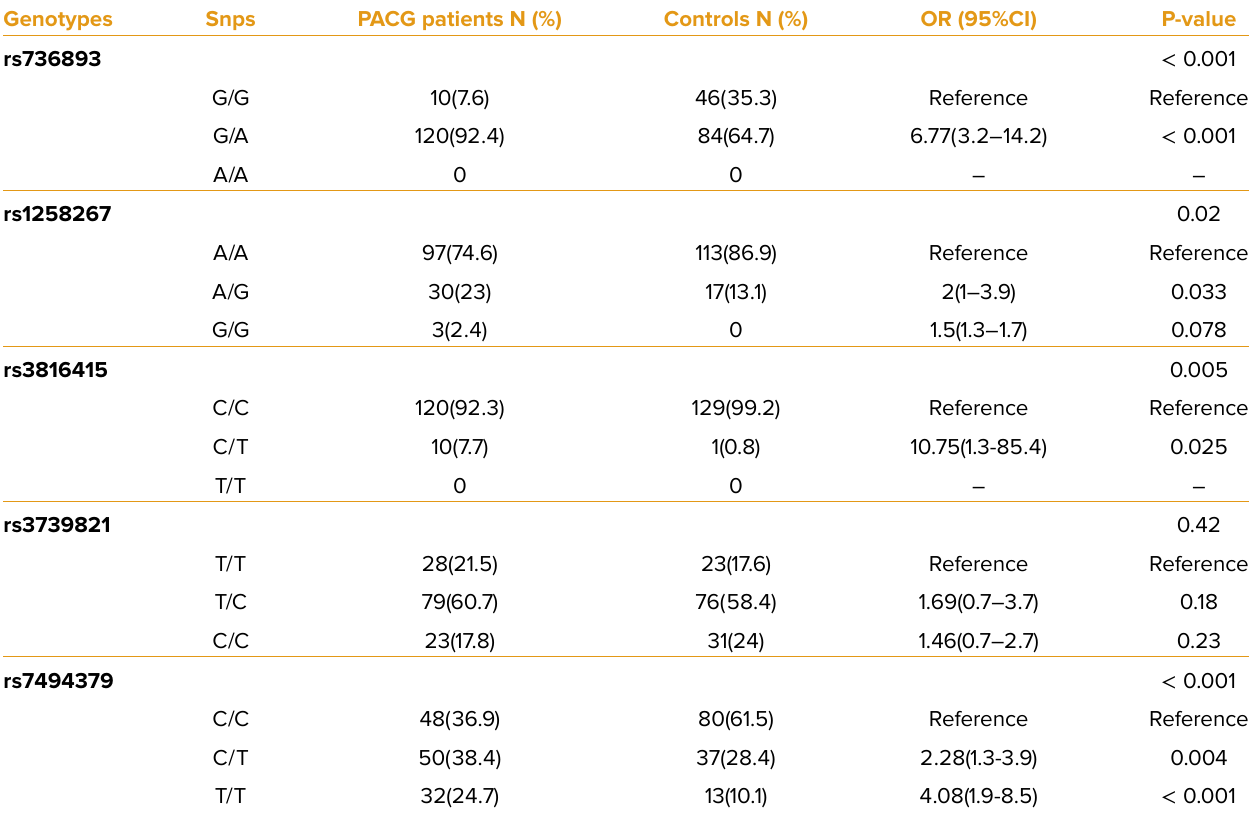
Table 3. Genotype frequencies